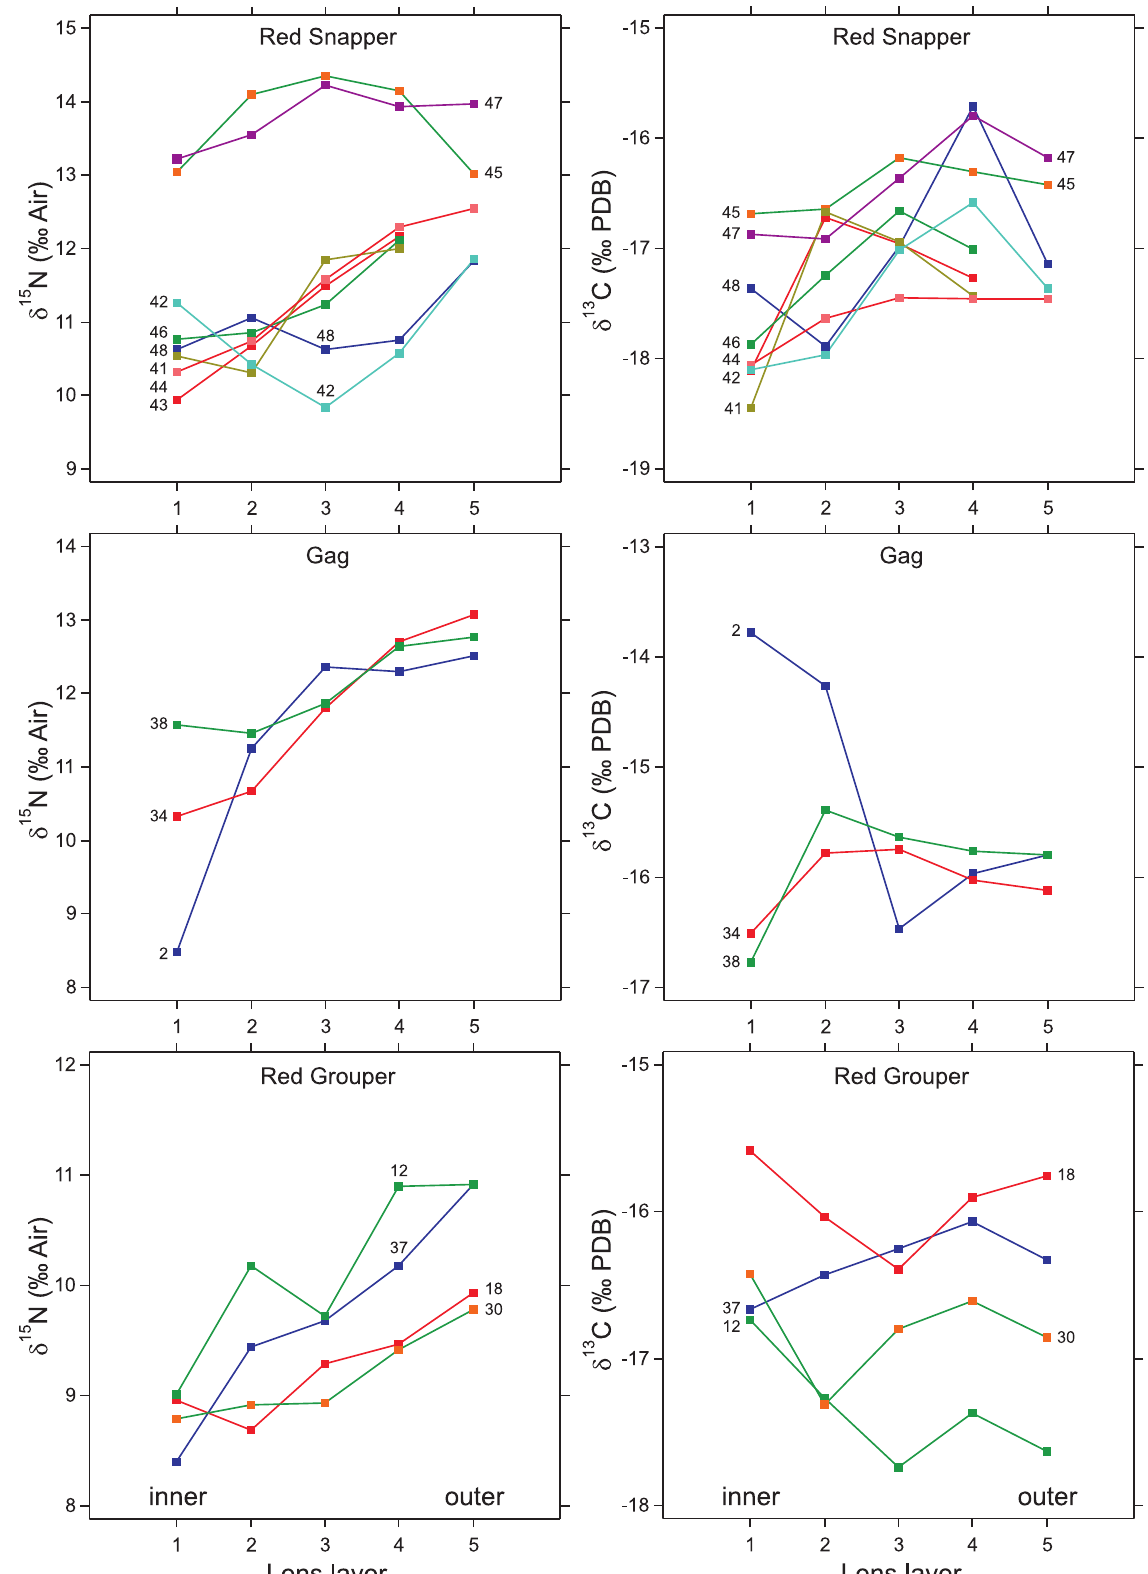
Figure 1. Low-resolution screening. Rapid screening of specimens to detect large-scale differences in isotopic history. Each plotted line is a different specimen; lines are labeled with specimen numbers. doi:10.1371/journal.pone.0108935.g001 PLOS ONE |